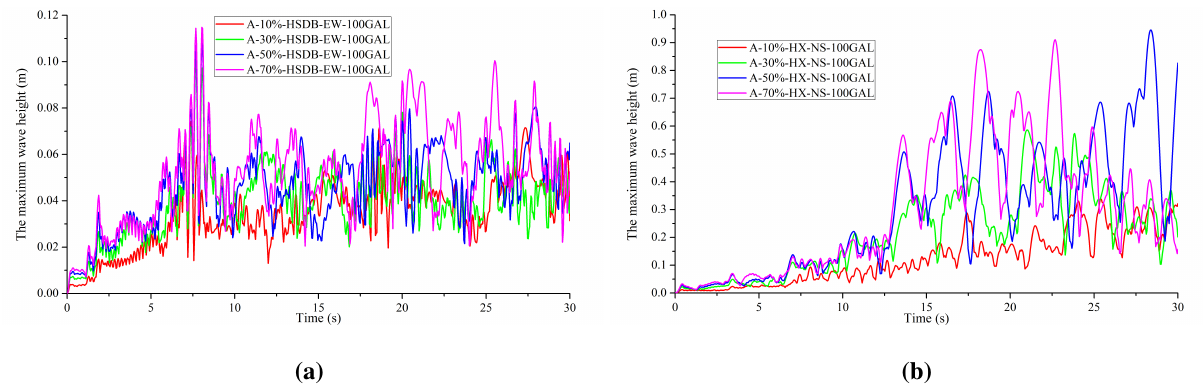
Fig. 4 Time-history curves of the maximum sloshing wave heights for tank A. (a) HSDB-EW seismic ground motion and (b) HX-NS seismic ground